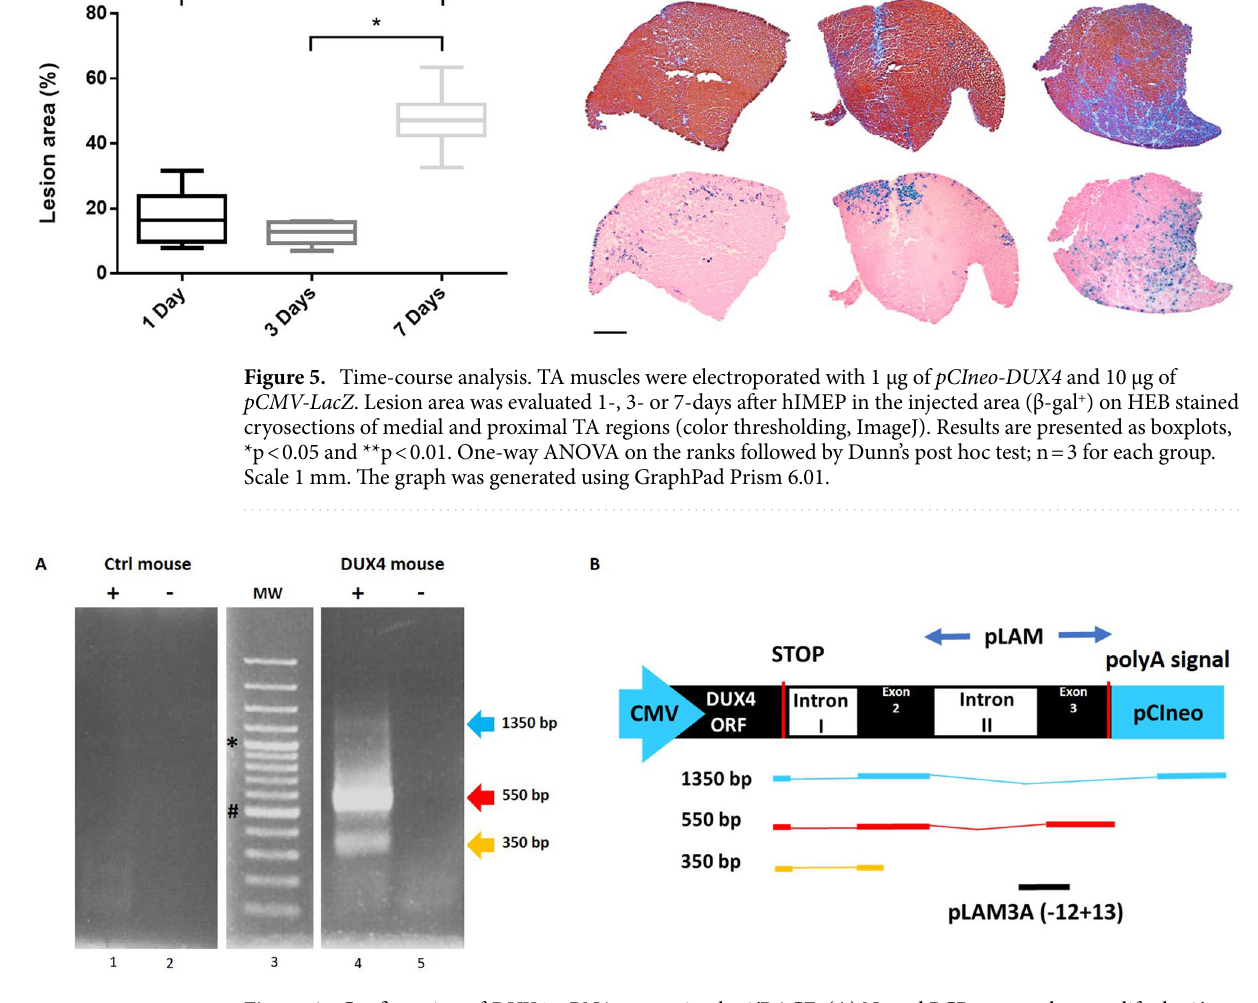
Figure 6. Confirmation of DUX4 mRNA expression by 3 ′ RACE. ( A ) Nested PCR was used to amplify the 3 ′ end of DUX4 transcripts from total RNA extracted from TA muscles electroporated with 1 µg of control (left panel) or DUX4-expression pDNA (right panel). Representative cropped gels. Lanes 1 and 2 come from one gel; lanes 3, 4 and 5 come from a second gel ran in parallel. Corresponding full-length gels are available in supplementary information (SI Fig. S2 online). 3 ′ RACE were performed 1-, 3- and 7-days post hIMEP. Wells ( − ) show negative controls without retro-transcription. Several fragments were detected (~ 1,350 bp, ~ 550 bp and ~ 350 bp; colored arrows) in each time point (not shown), cloned, sequenced and analyzed to confirm DUX4 specificity. ( B ) Schematic representation (not to scale) of 3 ′ RACE products analysis. In silico alignment confirmed conservation of vPMO [pLAM3A (− 12 + 13)] target sequence (black Zscan4c 84–86 . To this aim, total mRNAs were extracted from mouse TAs treated by hIMEP (1-, 3- and 7-days) using 1 µg of pCIneo-DUX4 or control plasmid pCIneo concomitant with reporter vector pCMV-lacZ . The 3 ′ RACE